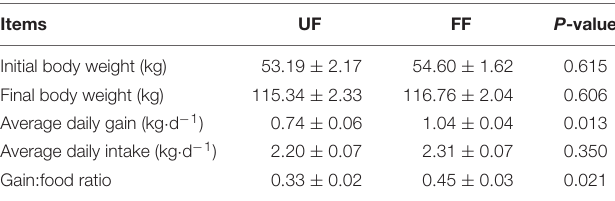
TABLE 3 | Effects of fermented meal on growth performance of grower-finisher pigs.